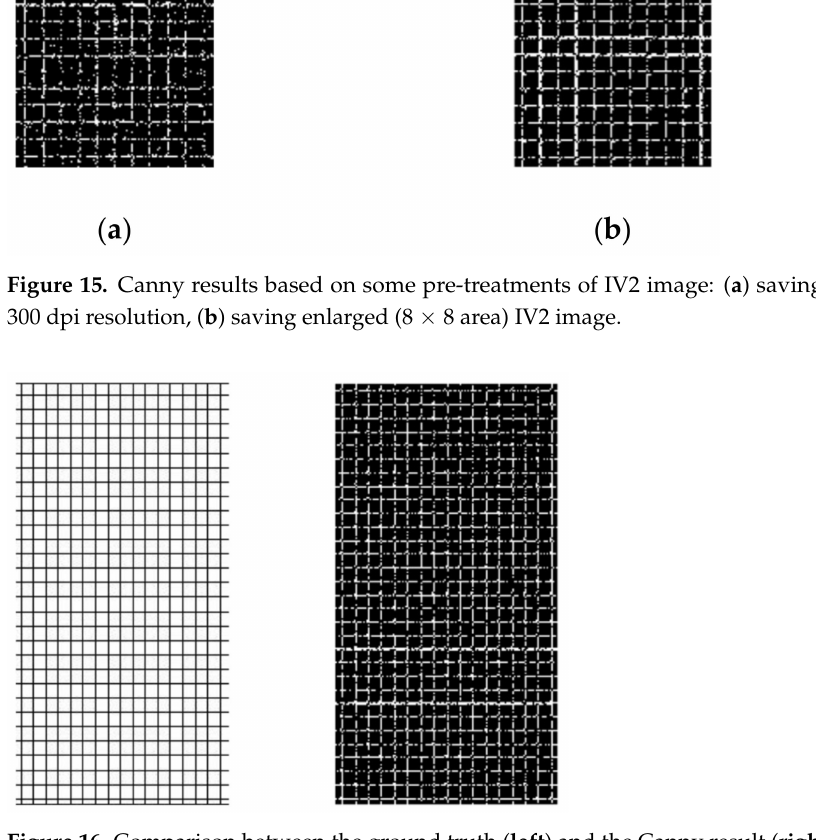
Figure 16. Comparison between the ground truth ( left ) and the Canny result ( right